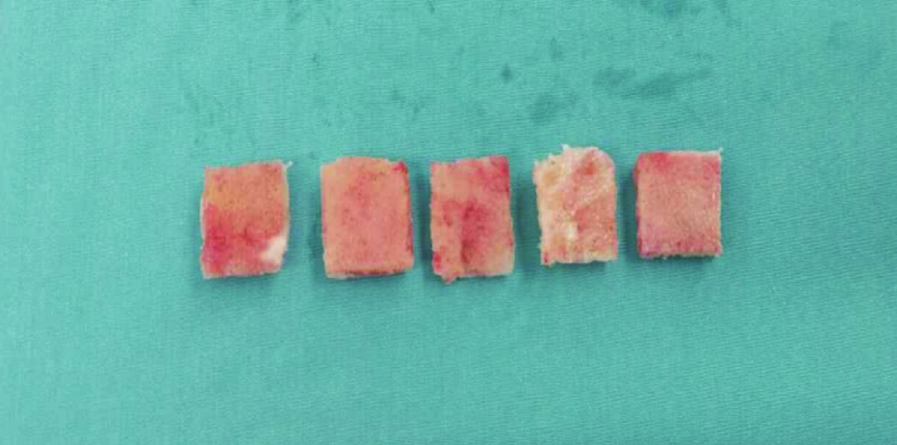
Bones specimens were prepared in uniform cubes Fig. 2: